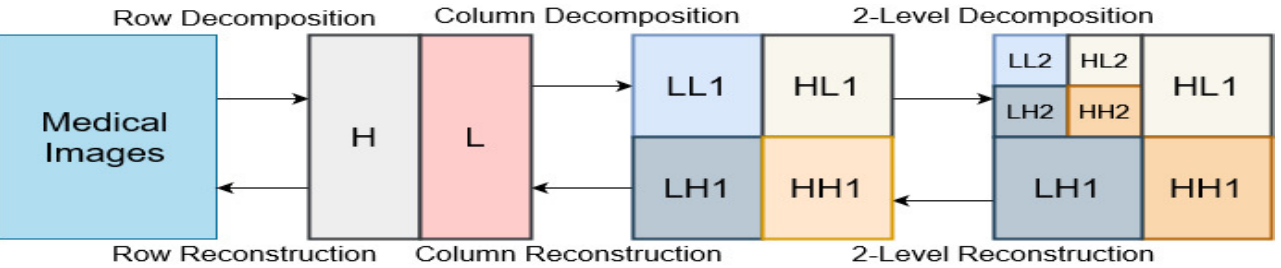
Figure 5. Two-level RDWT